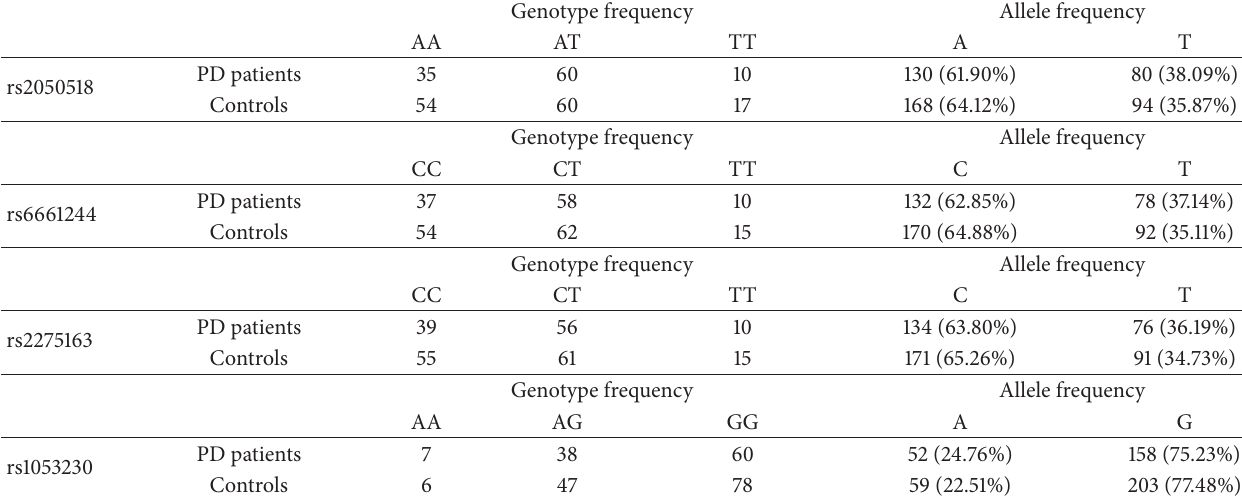
Table 3: Genotype and allele distribution of the investigated